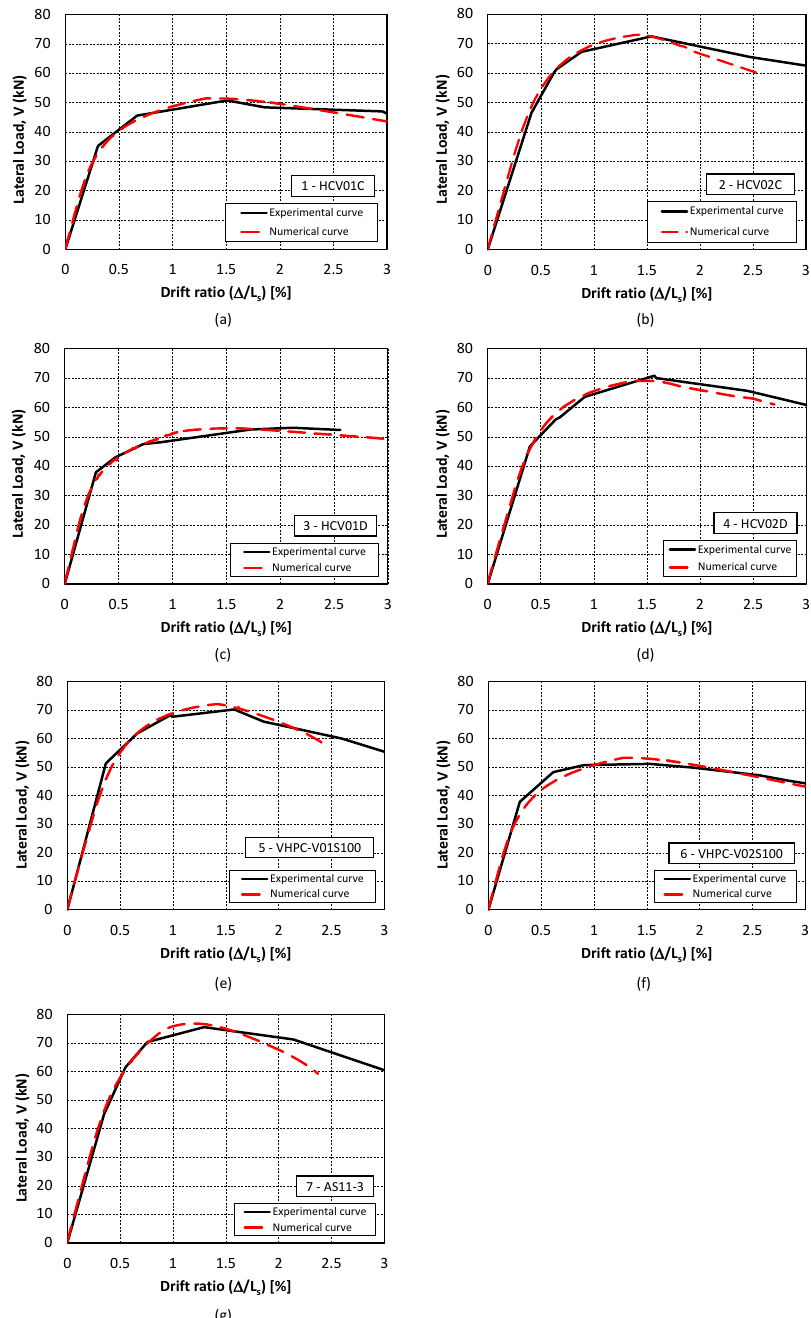
Figure 7. Calibration results: ( a ) Specimen 1: HCV01C; ( b ) Specimen 2: HCV02C; ( c ) Specimen 3: HCV01D; ( d ) Specimen 4: HCV02D; ( e ) Specimen 5: VHPC-V01S100; ( f ) Specimen 6: VHPC-V02S100; ( g ) Specimen 7: AS11-3.